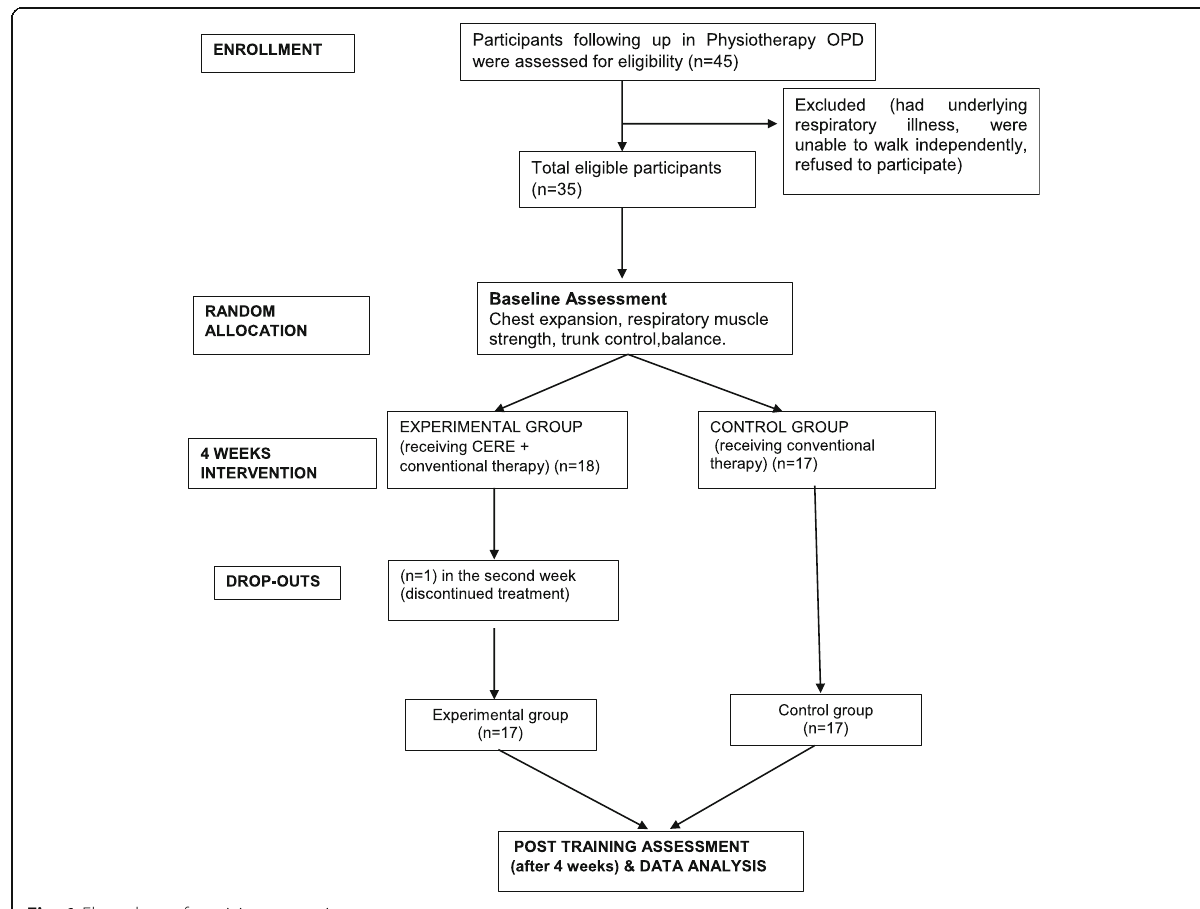
Fig. 1 Flow chart of participant